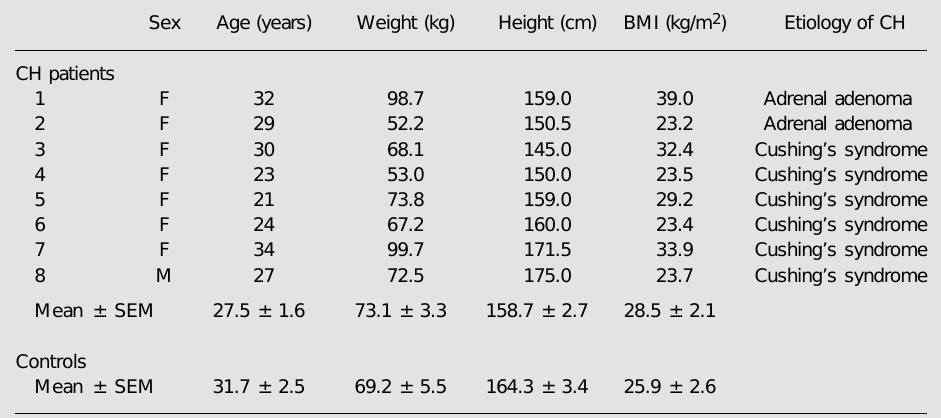
Table 1. Clinical characteristics of patients with chronic hypercortisolism (CH) and healthy subjects (controls).